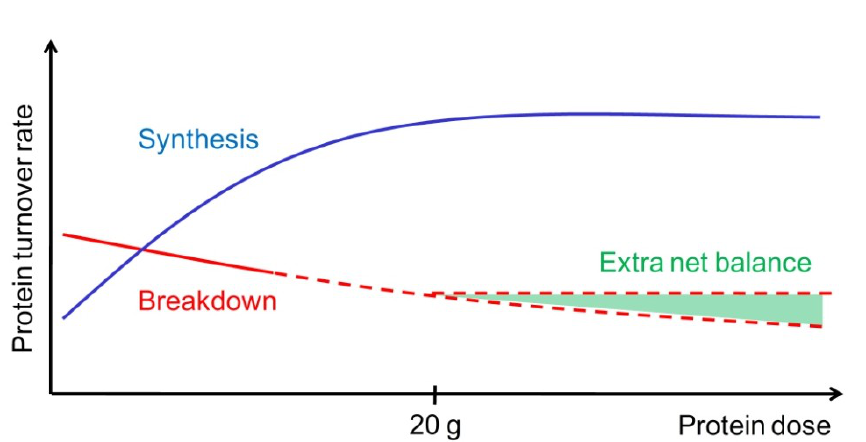
Figure 1. Illustration of muscle protein synthesis (MPS, blue curve) and muscle protein breakdown (MPB, red curve) rates in response to graded intake of protein. With increasing protein ingestion, MPS increases fast but reaches a plateau (at approximately 20 g high quality protein). In contrast to the MPS, MPB are hypothesized to decrease slightly but continuously with increasing protein or amino acid intakes. Therefore, the net muscle protein balance can possibly benefit from an even greater protein intake than known to stimulate MPS maximally (illustrated by the extra net balance area marked with